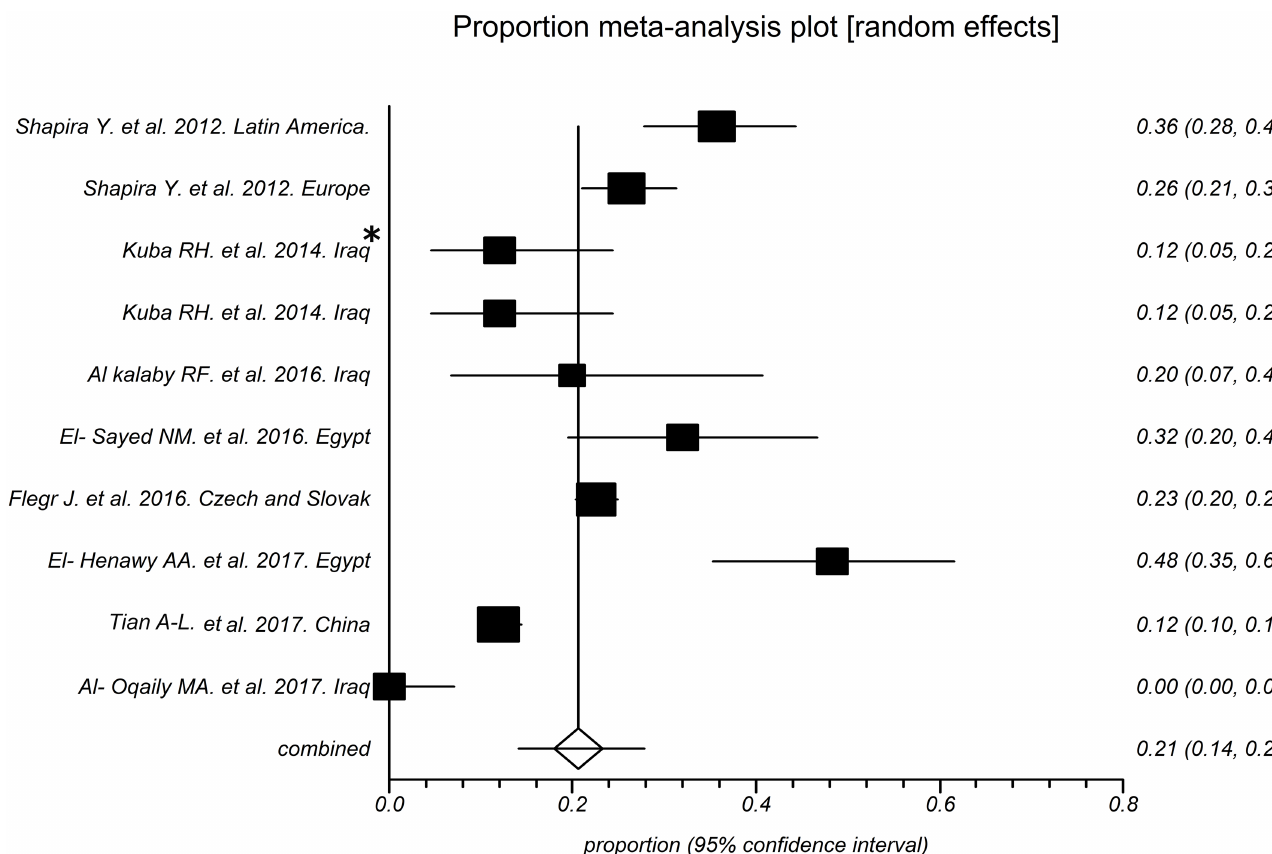
Fig 3. Forest plot of seroprevalence rates of toxoplasmosis in controls groups. (cid:3) Patients under treatment.